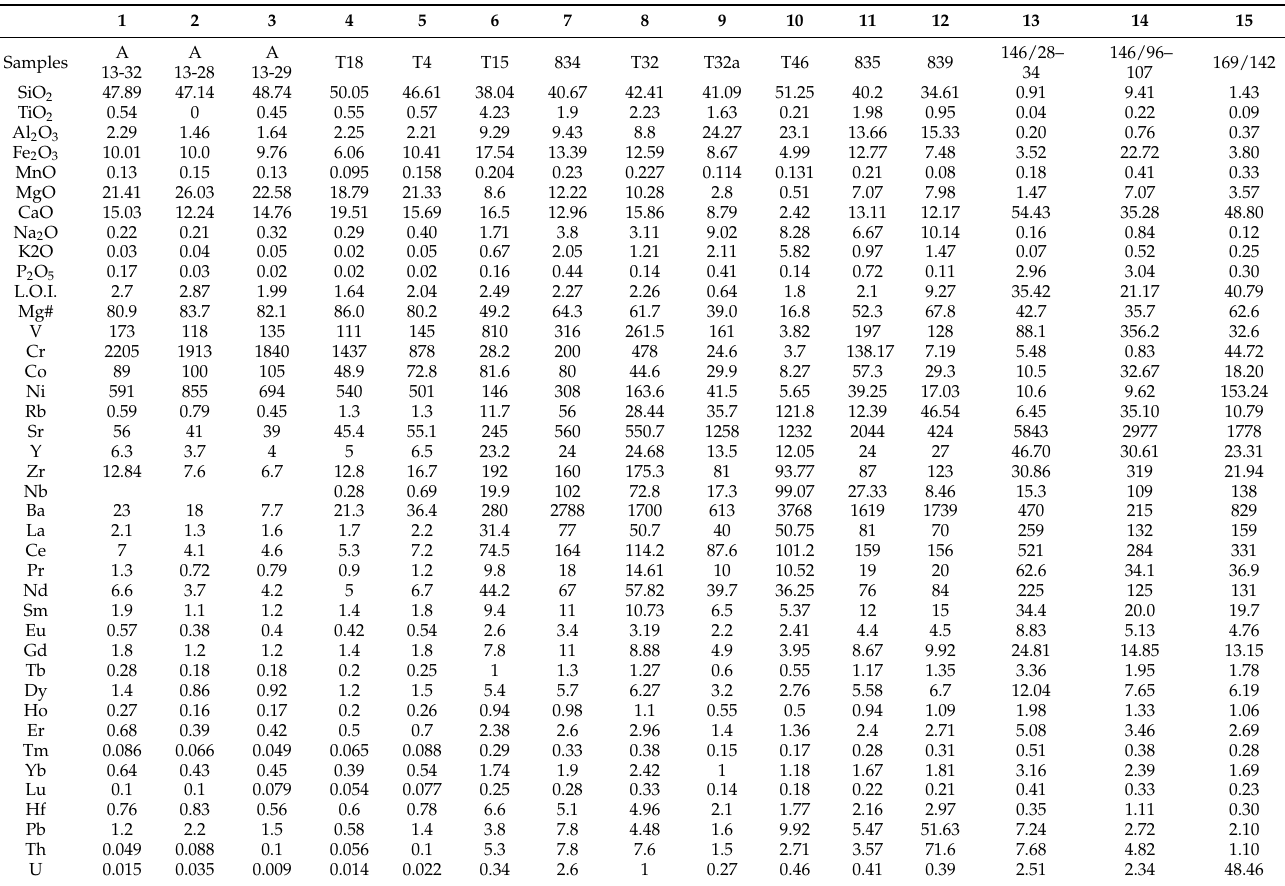
Table 1. Compositions of rocks of the Tiksheozero Complex (oxides in wt %, elements, in